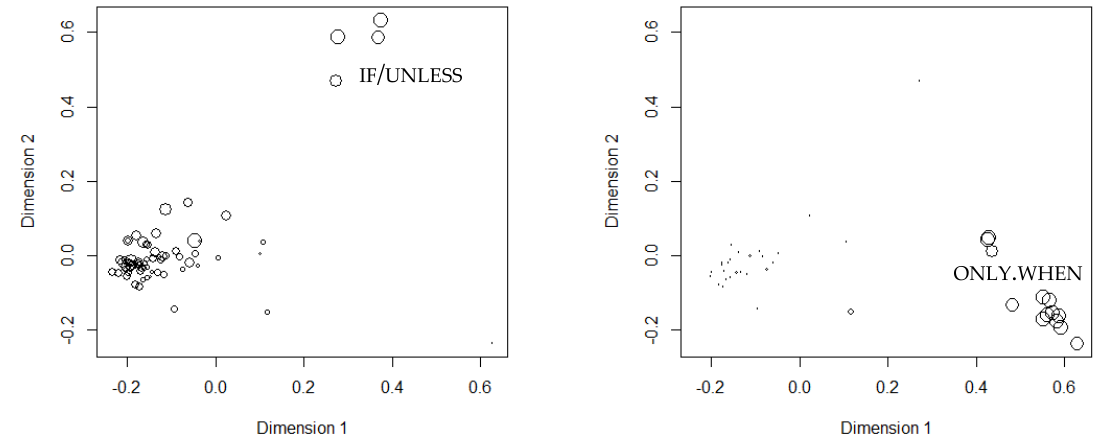
Figure 4. Polarity patterns (left NN; right AA) averaged over all languages.